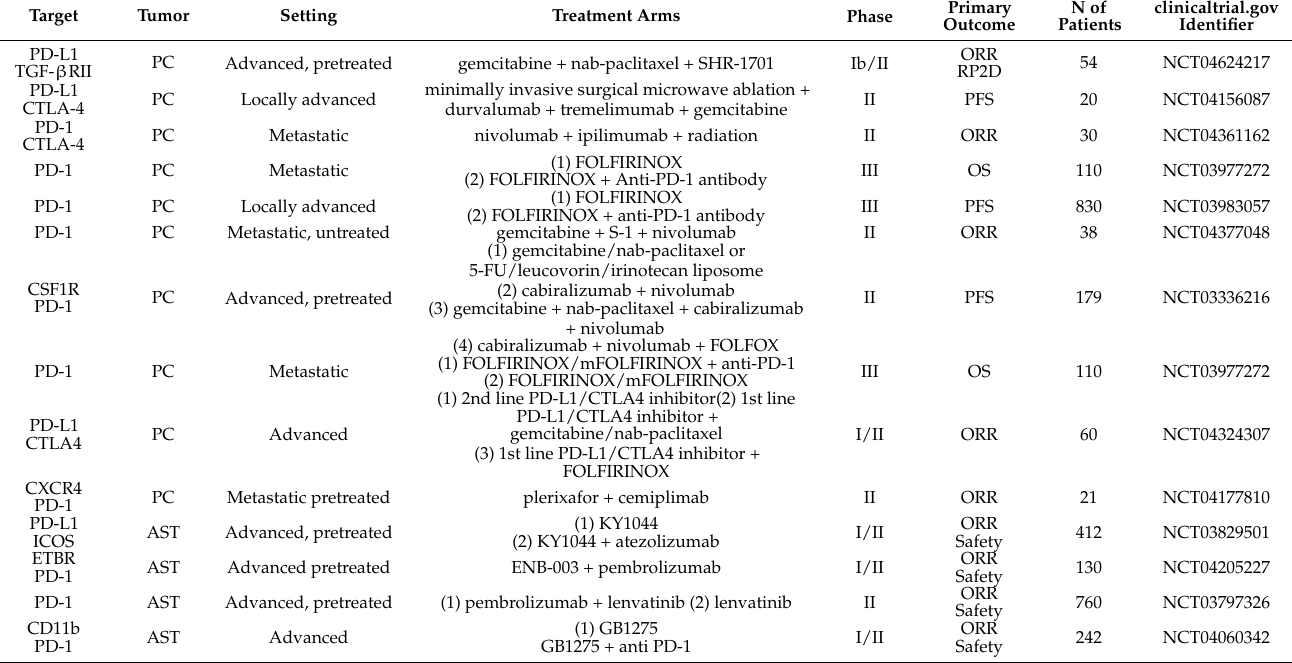
Table 3. Ongoing trials evaluating activity and efficacy of different immunotherapy strategies in PC (Clinicaltrials.gov last accessed 10 June